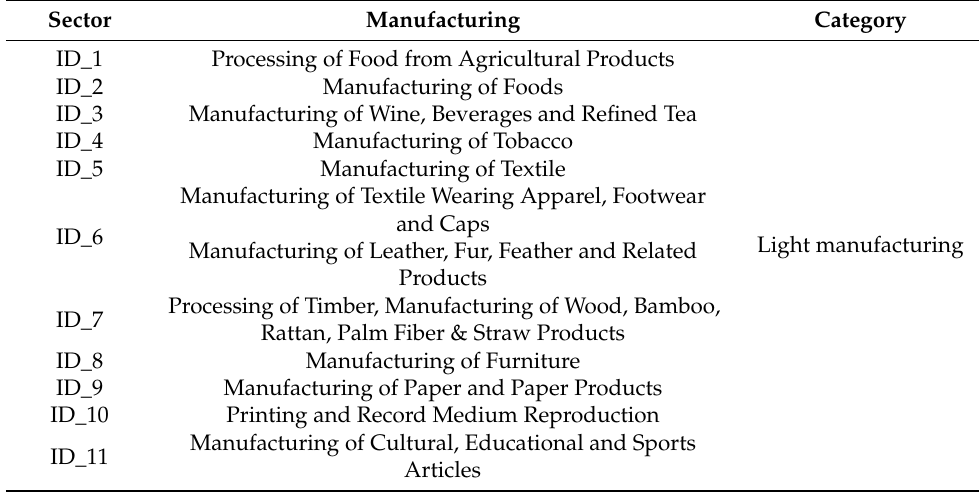
Table 4. The classification of Shenzhen’s